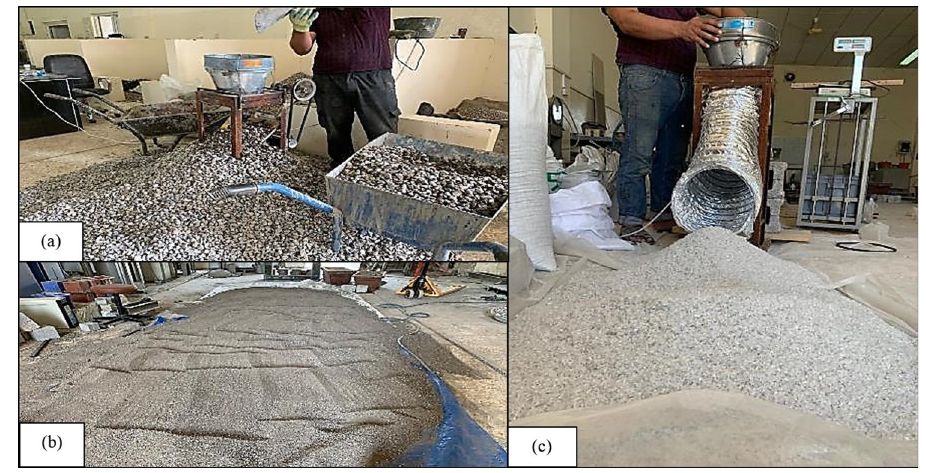
Fig 1. Sieving of aggregates: (a) coarse; (b) fine; and (c) PET.